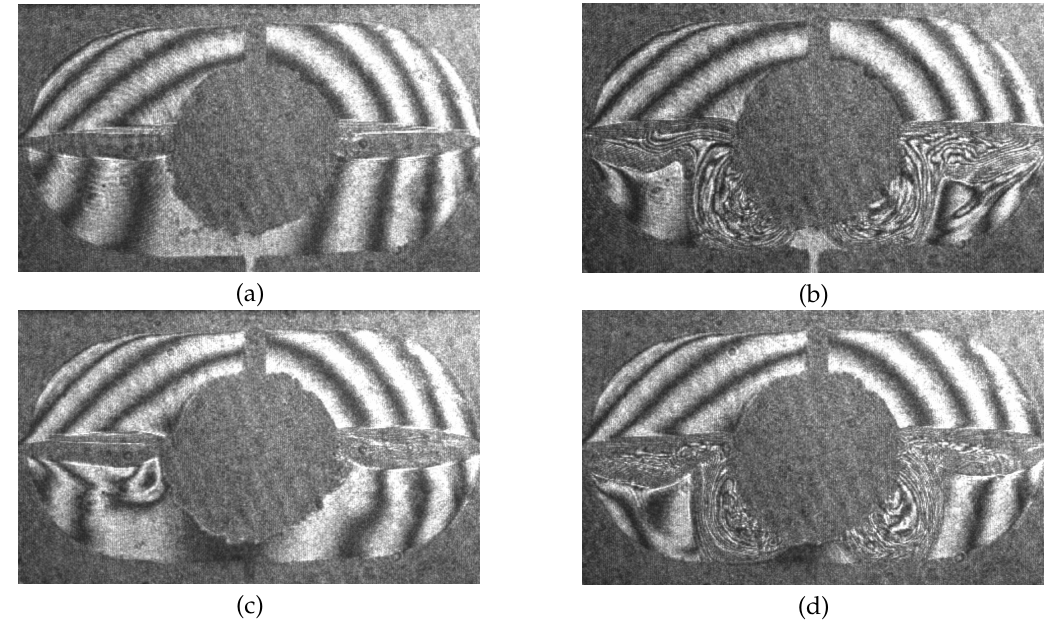
Figure 8. Evolution of the concentration field of isopropyl alcohol near the air bubble placed in the center of the cavity for C 0 = 15 wt.% and inflow velocities from both inlets V = 0.02 mm/s: t = 240 s ( a ); t = 270 s ( b ); t = 420 s ( c ); and t = 450 s ( d